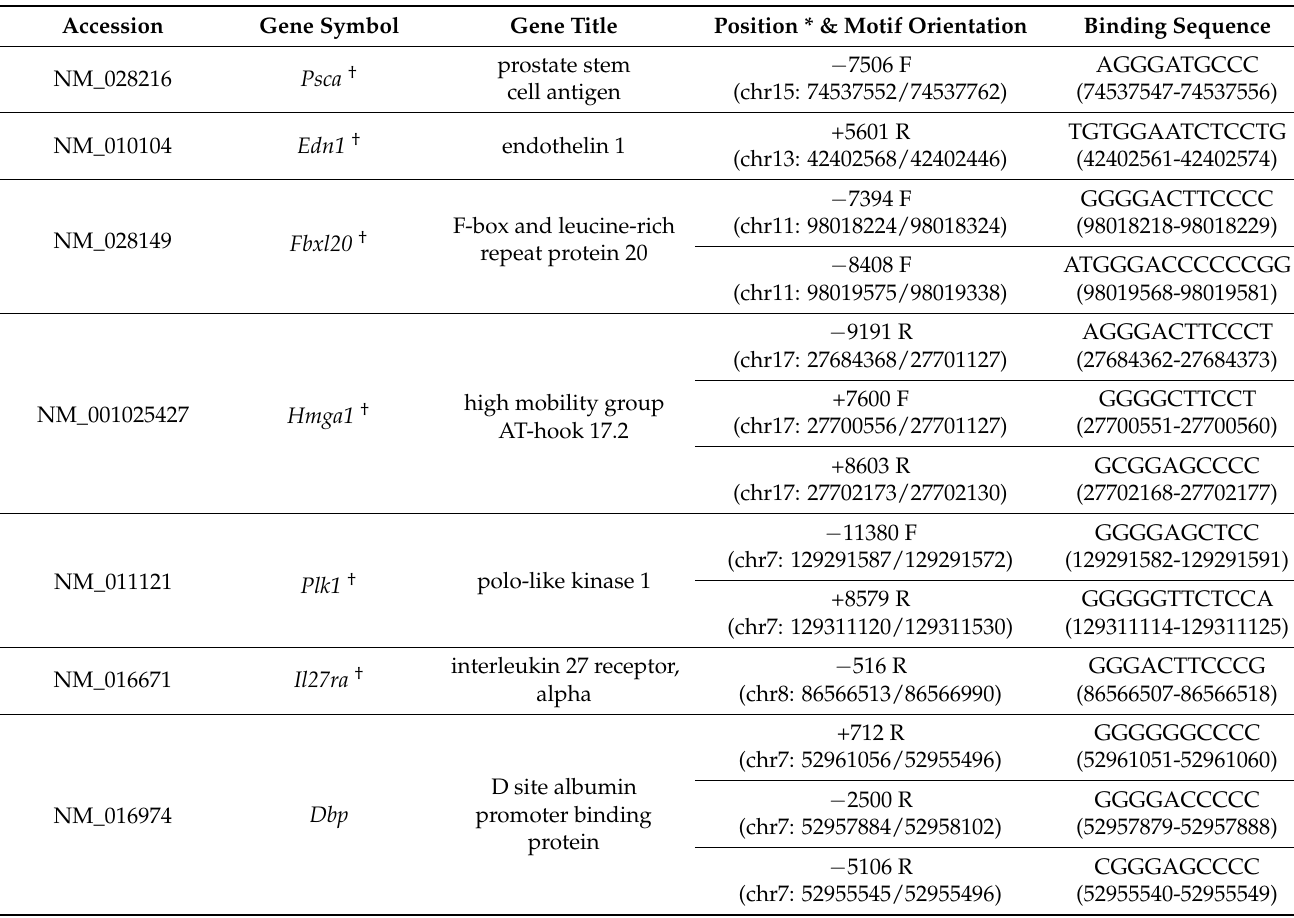
Table 5. Potential NF- κ B binding motifs on selected Nfkb1 -dependently regulated lung genes after ozone (O 3 )